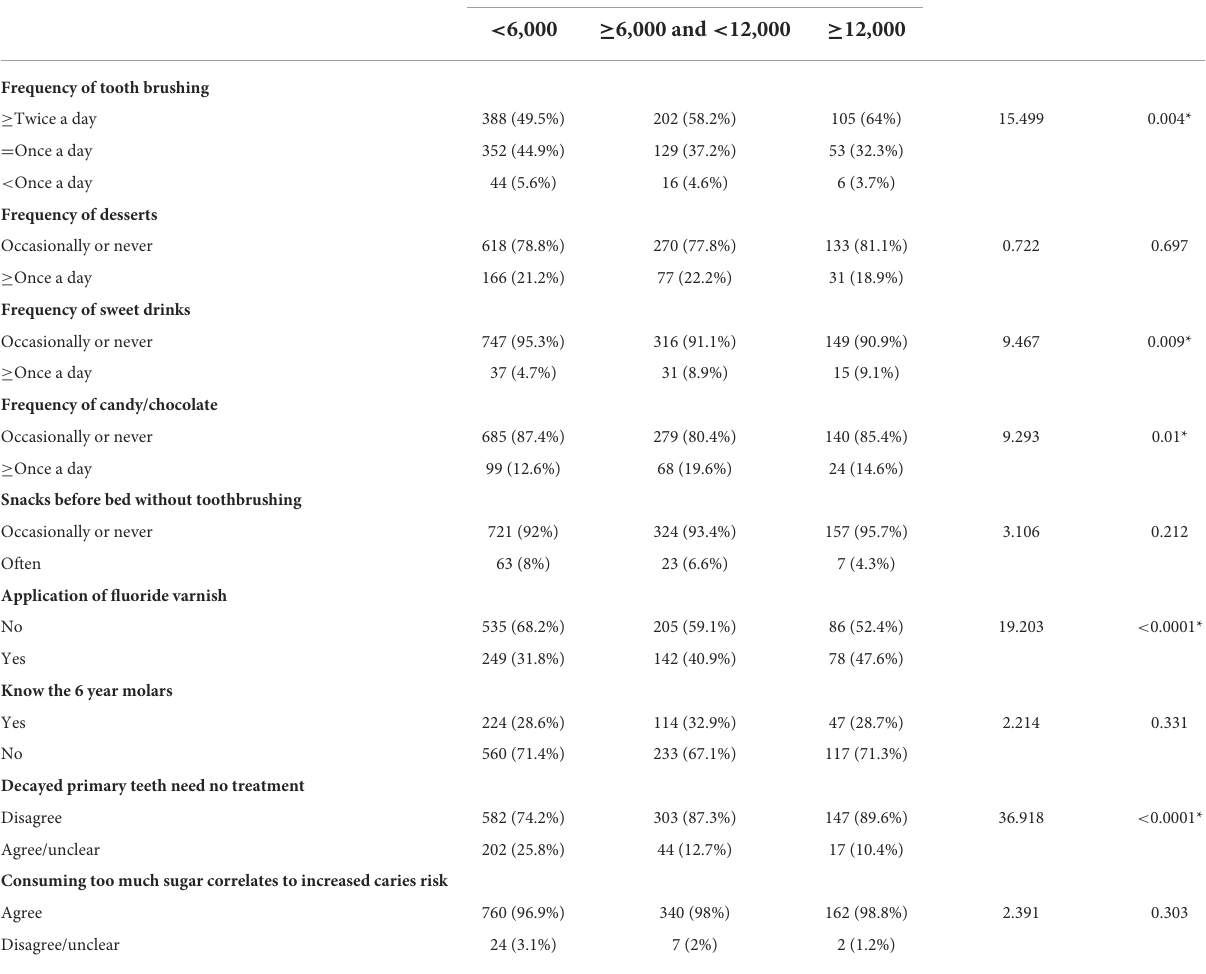
TABLE 6 Monthly family income and different variables ( N =